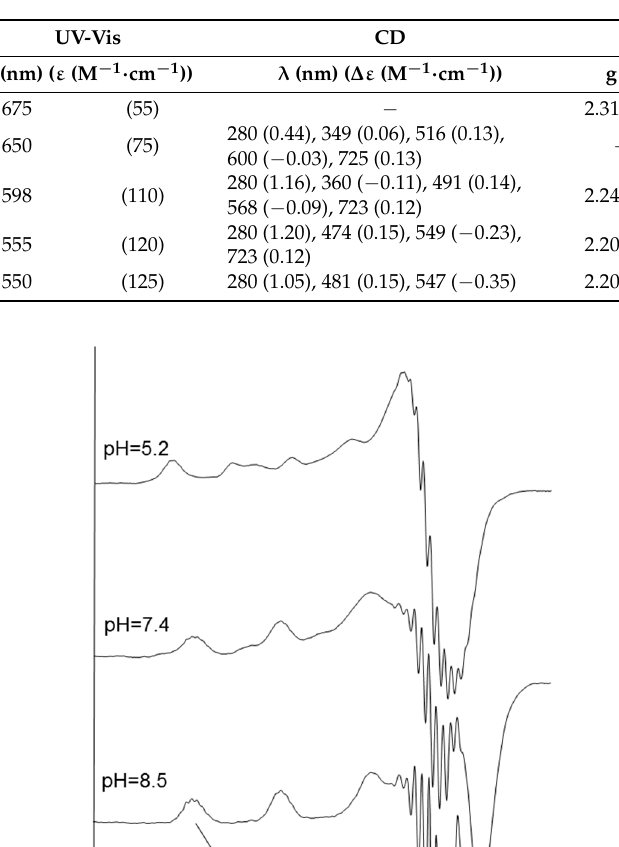
Table 4. Spectroscopic parameters of copper(II) complexes with Ac-SLHHLG-NH 2 peptide at